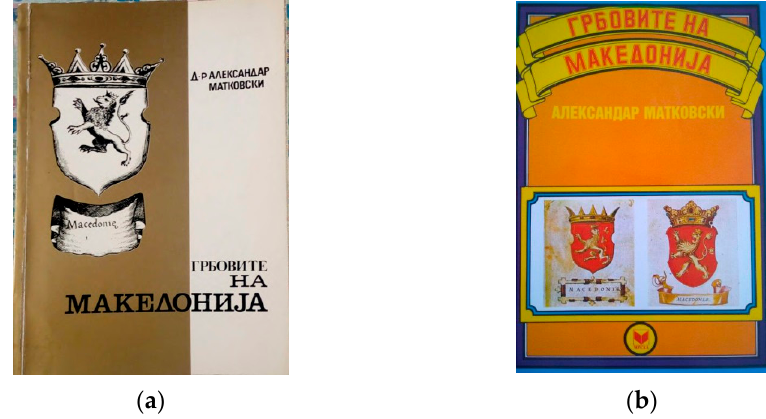
Figure 17. ( a ) One of the several 1970 covers; ( b ) 1990